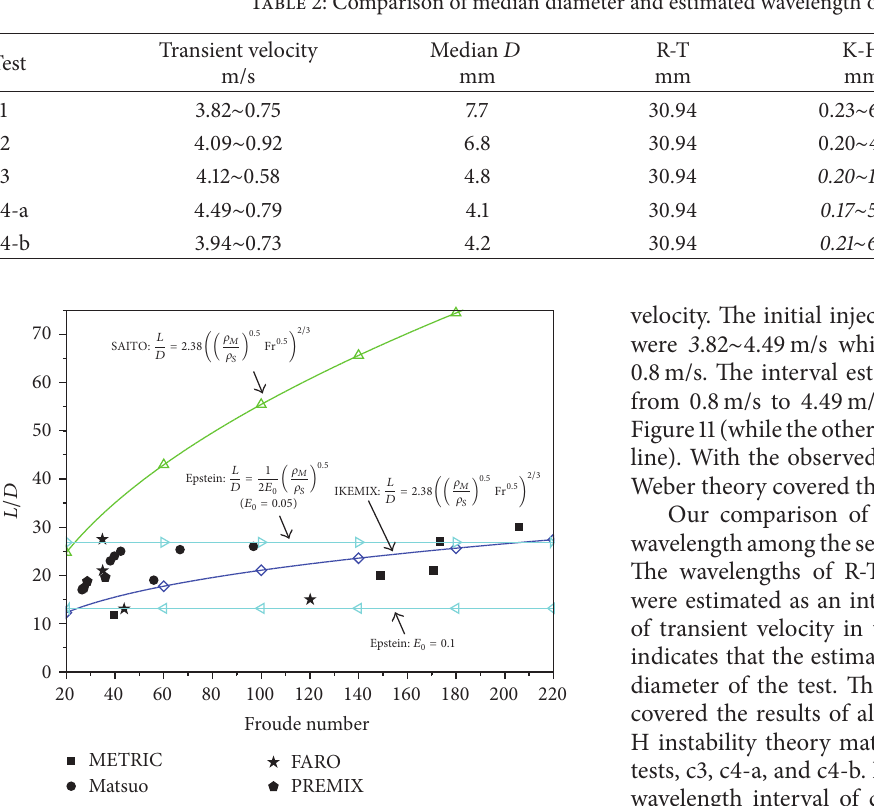
Table 2: Comparison of median diameter and estimated wavelength of theories.